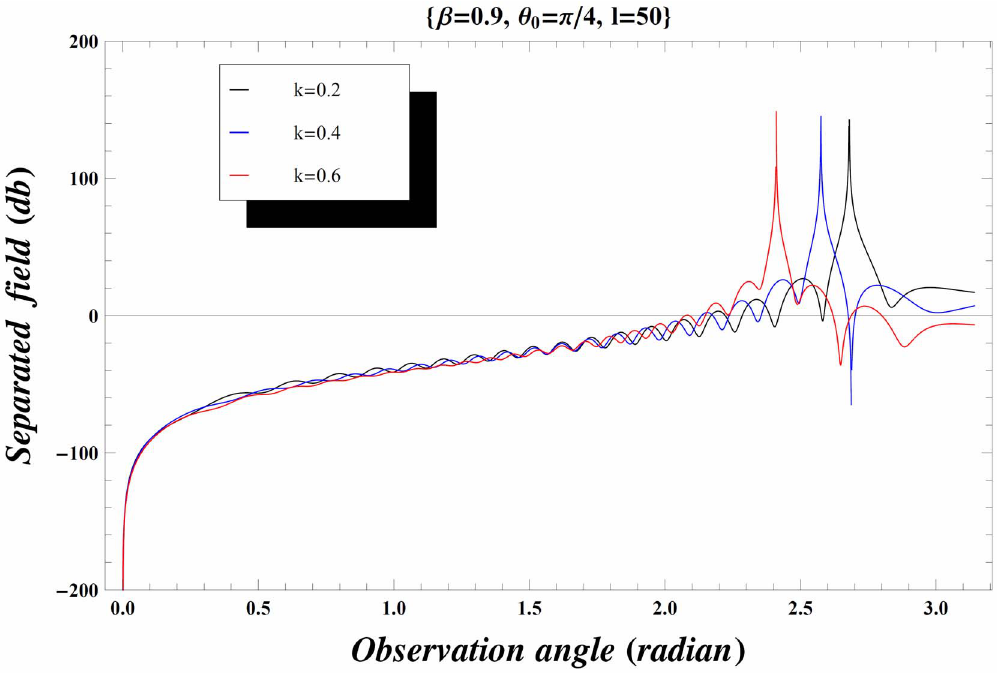
Figure 11. Separated field versus observation angle for different values of wave number k when b 1 ~ 0 : 9 and the plate length l ~ 50 :